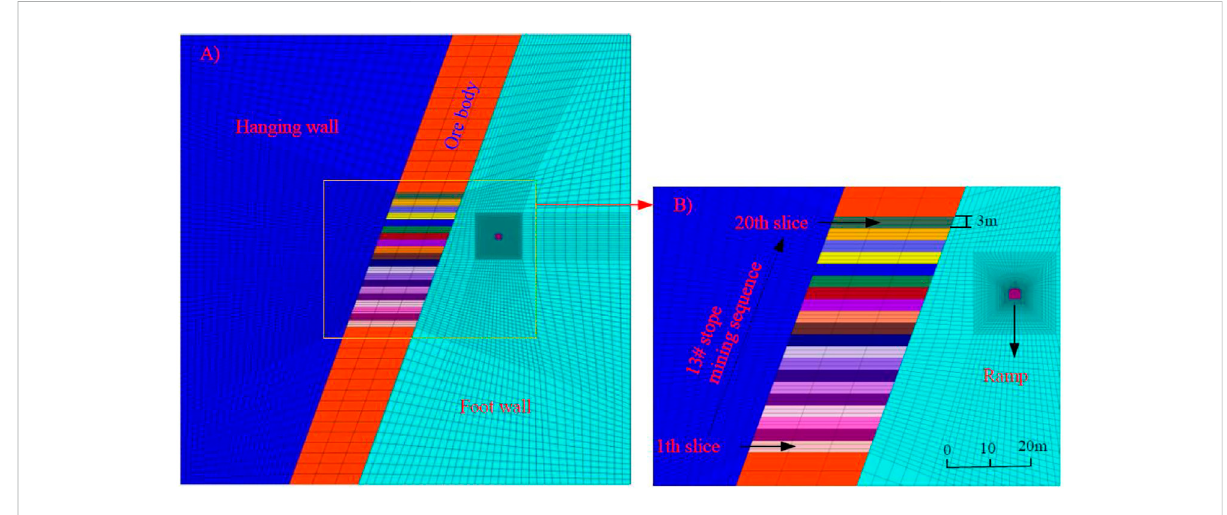
FIGURE 3 Numerical model of the 13# stope and ramp.